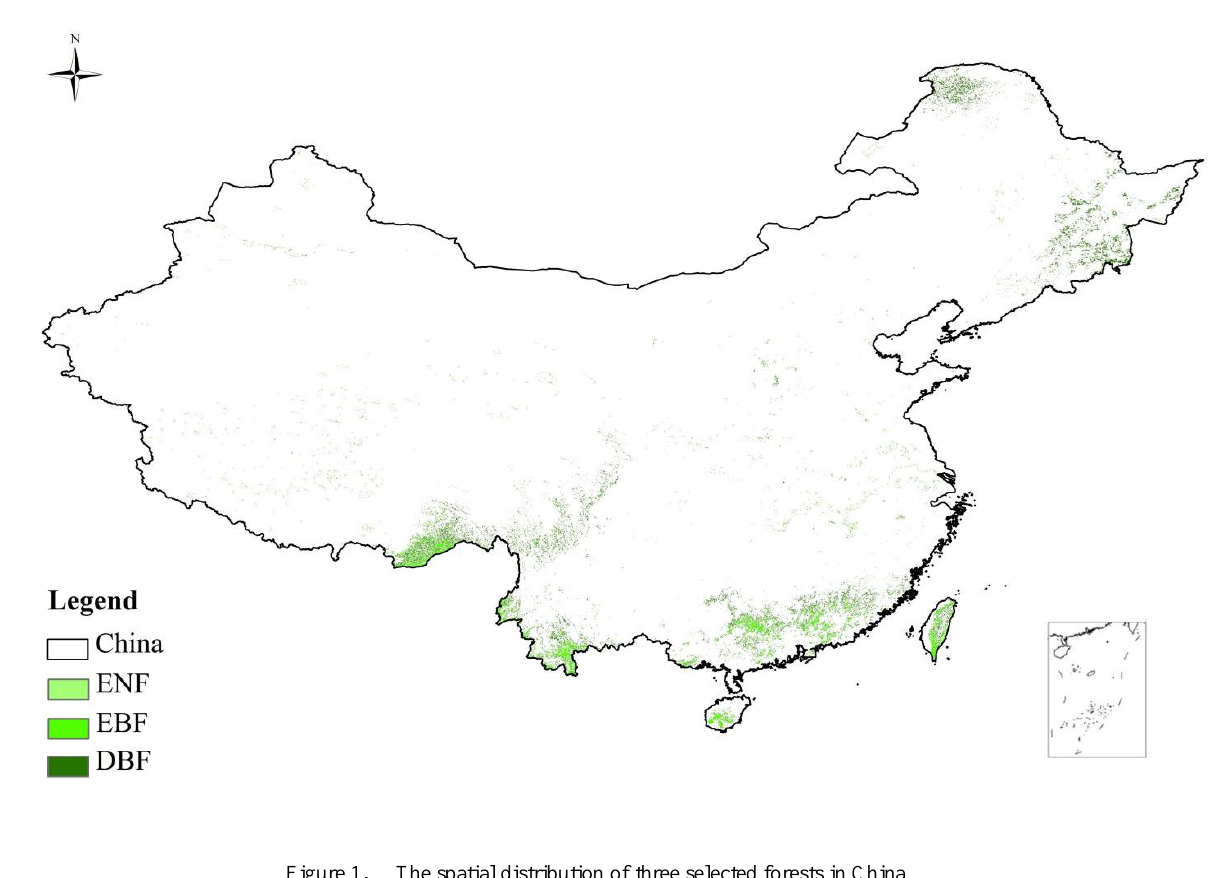
Figure 1 ． The spatial distribution of three selected forests in China